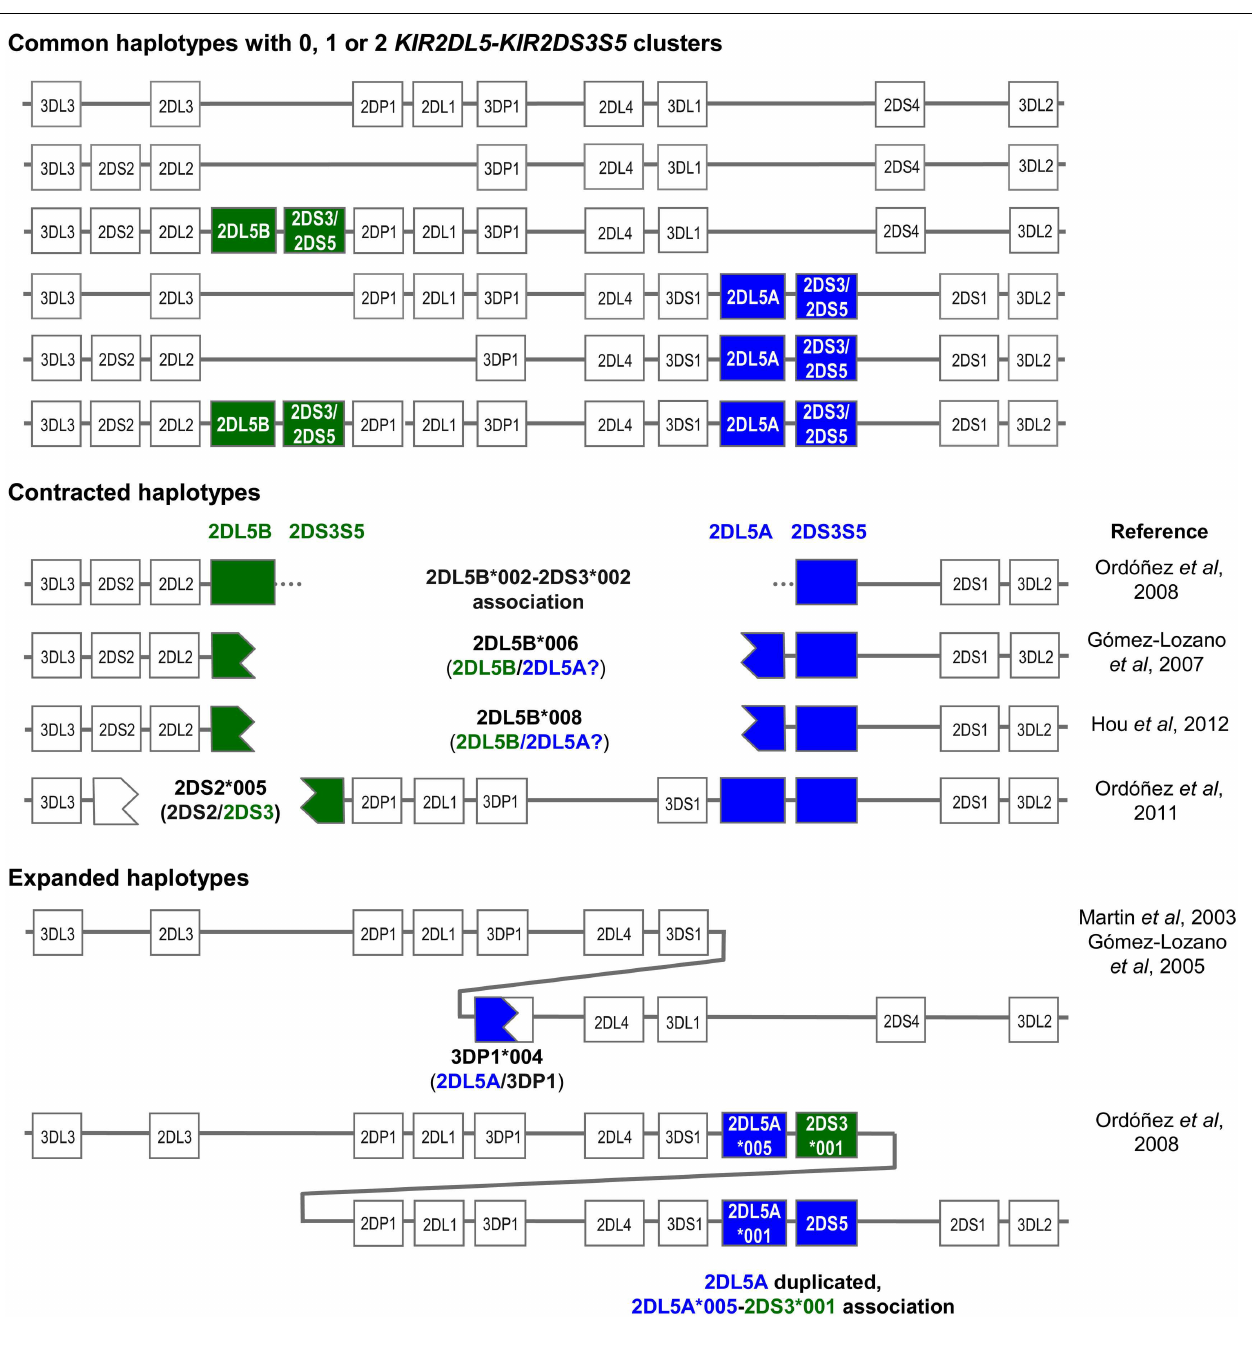
FIGURE 1 | Copy number variation and allelic polymorphism of KIR2DL5 - KIR2DS3S5 clusters contribute substantial diversity to KIR haplotypes.